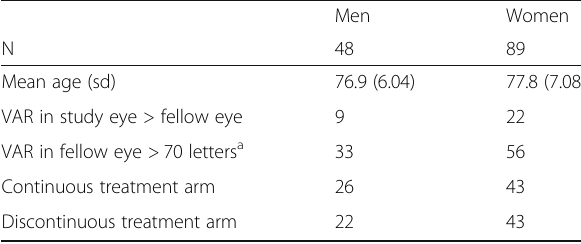
Table 2 Participant